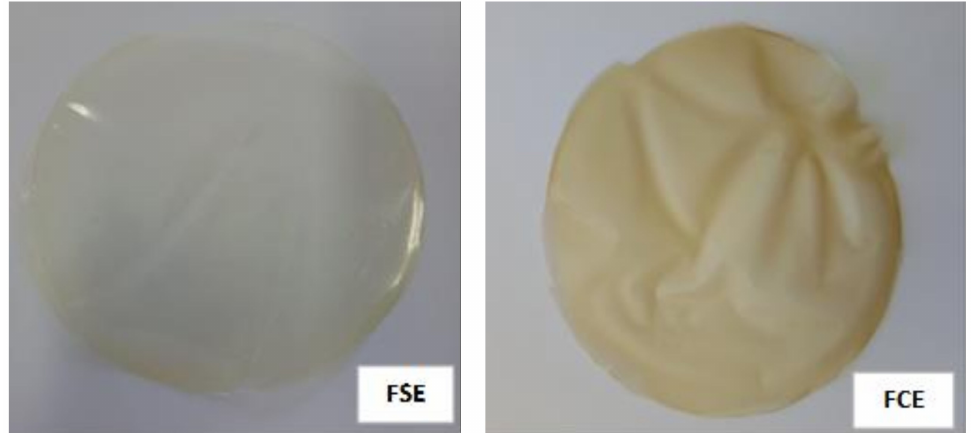
Figure 3. Appearance of bioplastic films, without (FSE) and with extract (FCE).